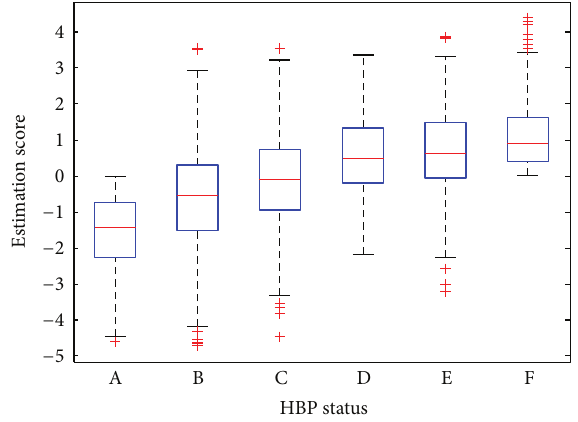
Figure 5: Box plots of the distribution of estimation scores for samples of different HBP status. The model without FPG is used. (A) Healthy, (B) suspected white-coat HBP, (C) borderline 1, (D) borderline 2, (E) quasi-HBP, and (F)